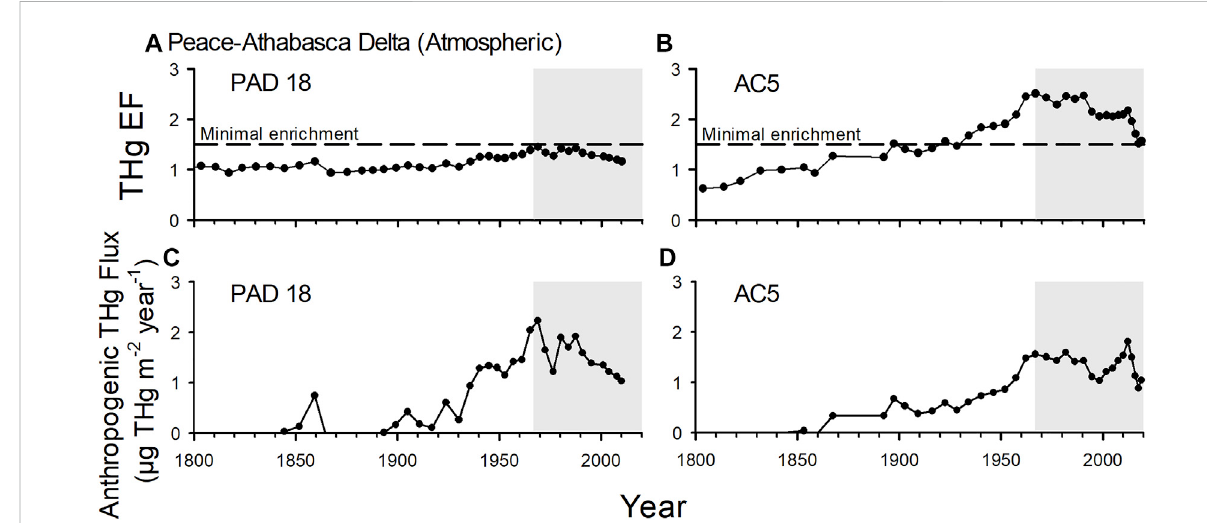
FIGURE 3 TimeseriesofTHgenrichmentfactors(EFs)relativetotheaveragepre-1900concentrationatuplandlakesinthePADregion: (A) PAD18and (B) AC5. The bottom two graphs are time series of focus factor corrected anthropogenic Hg fl ux for (C) PAD 18 and (D) AC5. The grey shaded region denotes the interval of oil sands mining and processing activities on the Lower Athabasca River beginning in